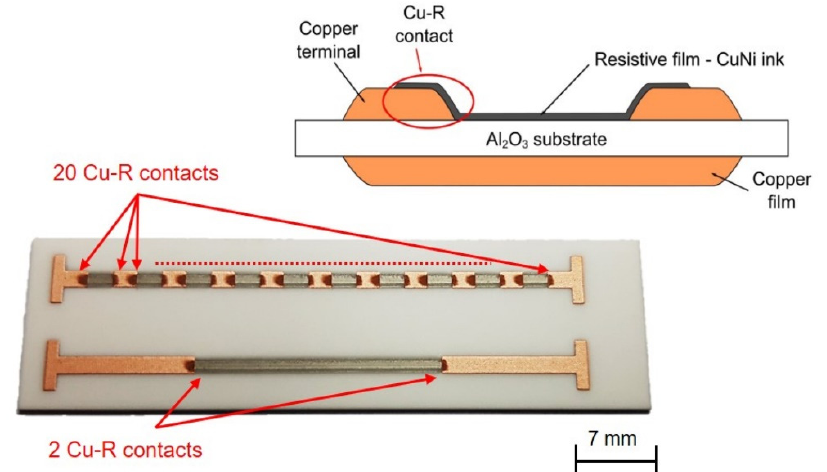
Figure 1. Formed IRP and the structure of the resistor with the copper–nickel resistive film. Cu-R contact means the contact between the copper film and copper–nickel resistive film, this contact causes contact resistance.